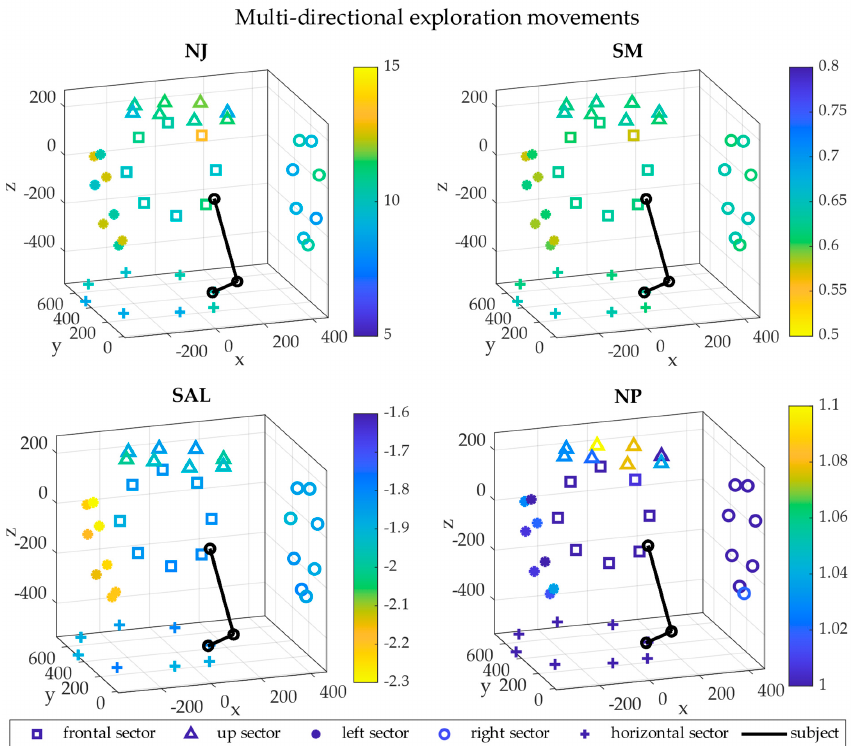
Figure 7. 3D maps in cartesian coordinates—EXP movements. The 3D maps representing the level of smoothness are reported in cartesian coordinates referred to the shoulder. The five sectors are visualized in 3D space with different shapes: frontal (square), up (triangle), left (bullet), right (circle) and horizontal (cross). The upper limb starting position is represented in black for a typical subject for visual reference. Each point is the average across repetitions and subjects and their colors indicate the magnitude of the metrics. The x axis points to the right of the subject, the y axis points frontally and the z axis is vertical. Appl. Sci. 2022 , 12 , x FOR PEER REVIEW